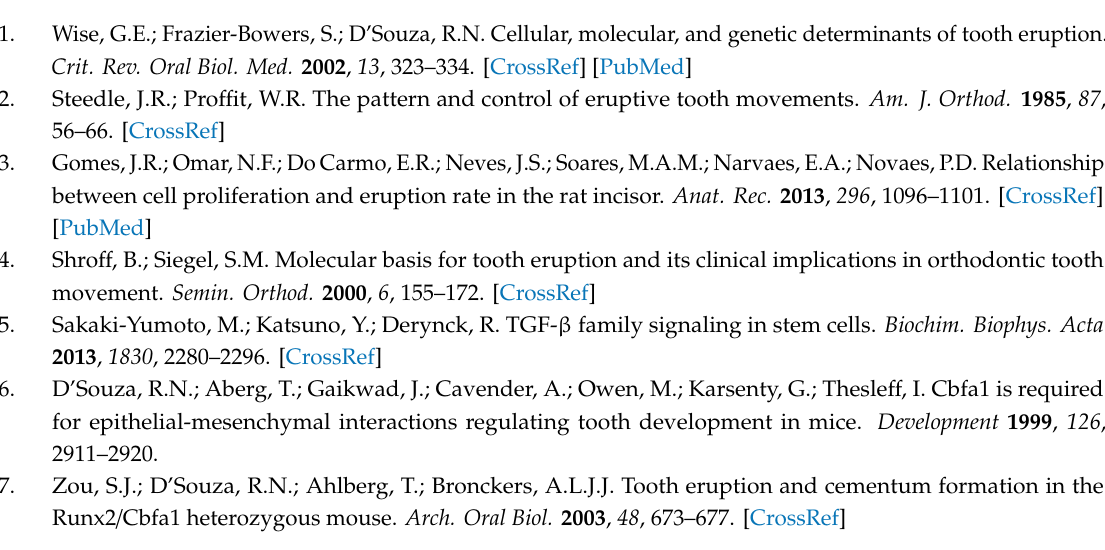
Figure S1: Full length blot of Figure 1. Figure S2: Relative expression level to β -actin in the cellular experiments. Figure S3: Full length blot of Figure